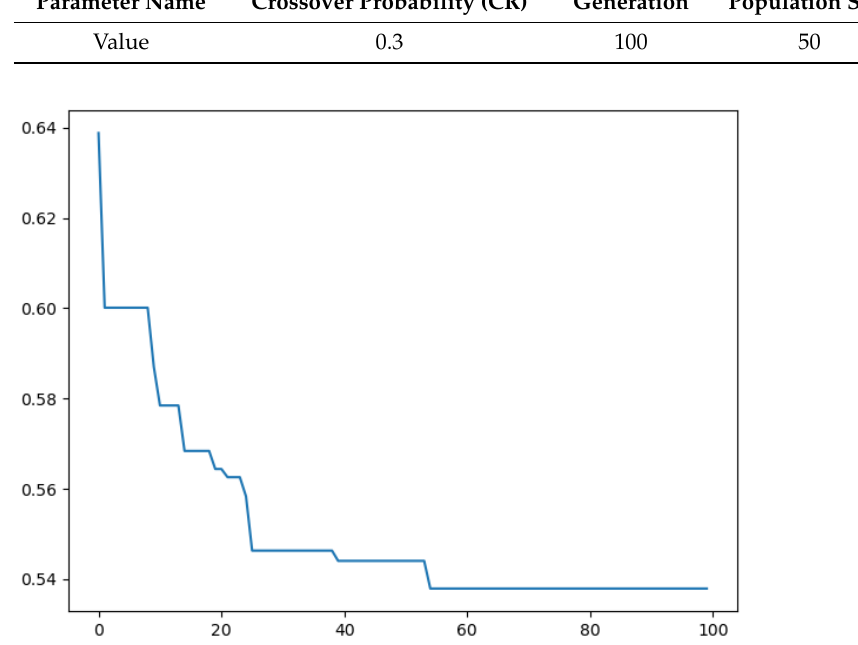
Figure 15. Convergence curve.